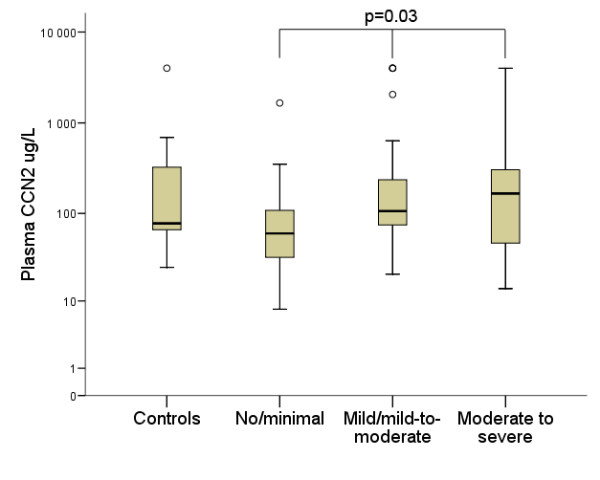
Relationship between plasma connective tissue growth factor and degree of valvular regurgitation. Box plot displaying the relationship between plasma connective tissue growth factor (CCN2) levels and the degree of tricuspid and/or pulmonary regurgitation. Median, interquartile range, and maximum and minimum values are shown. Due to the presence of extreme outliers, plasma CCN2 levels are plotted on the y-axis using a logarithmic (log10) scale. The highest plasma CCN2 levels were seen in the patients with moderate to severe right-sided valvular regurgitation (Kruskal-Wallis test, p = 0.03).